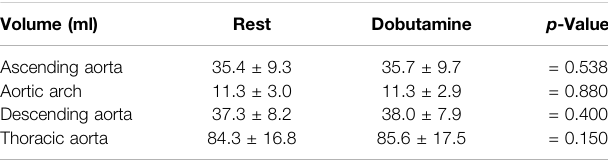
TABLE 2 | Volumes for all regions of the thoracic aorta at Peak TKE total . Volume (ml)